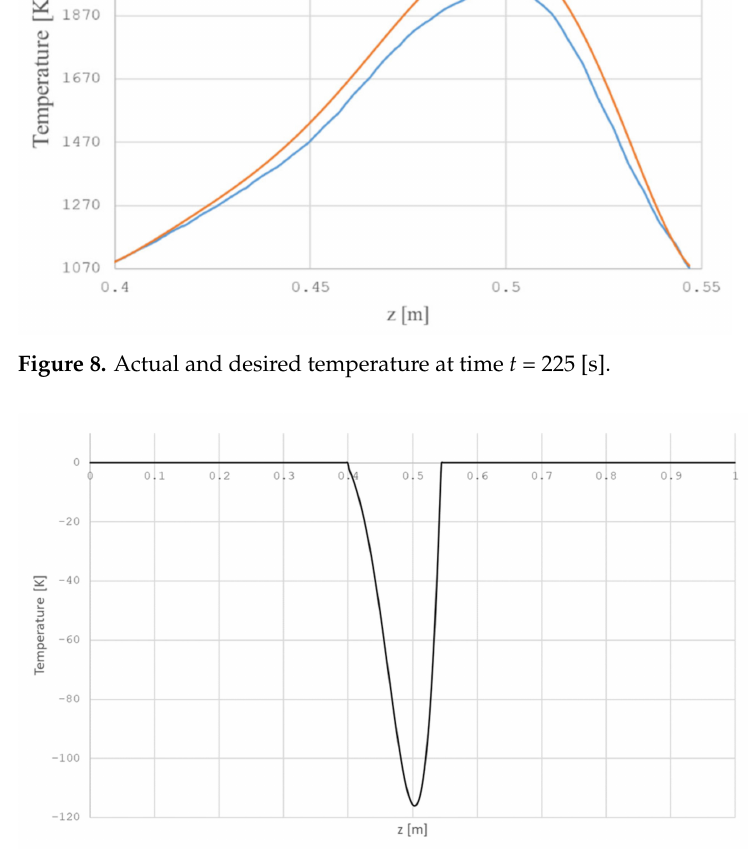
Figure 9. Temperature distribution at the initial time.